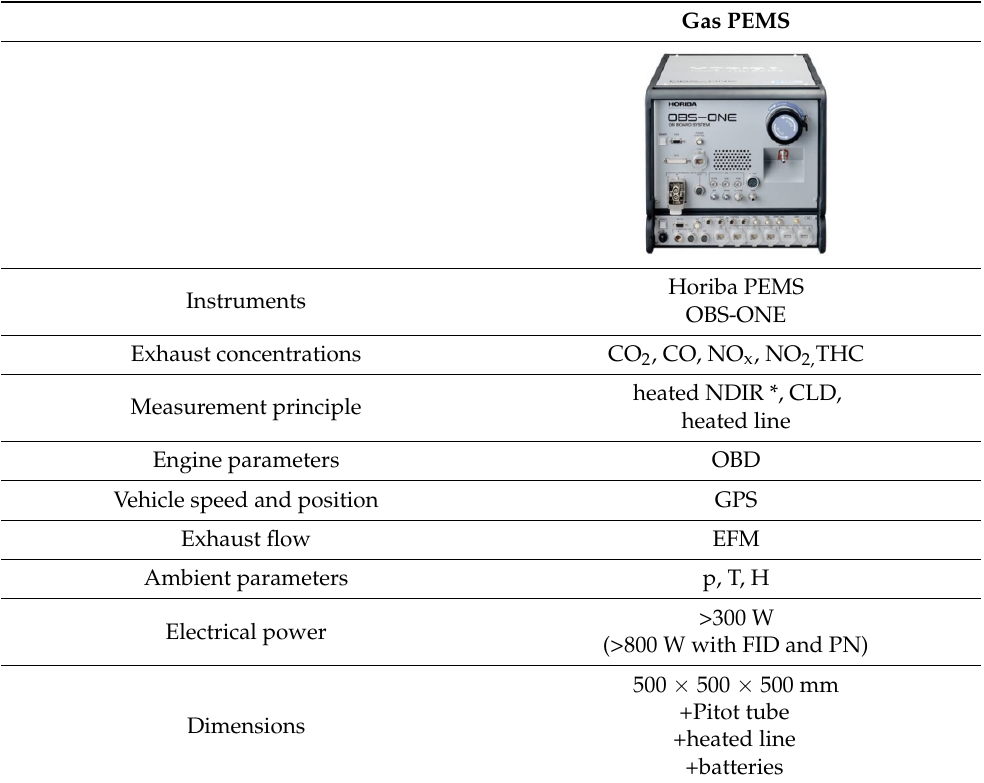
Table 2. Data of the applied GasPEMS.